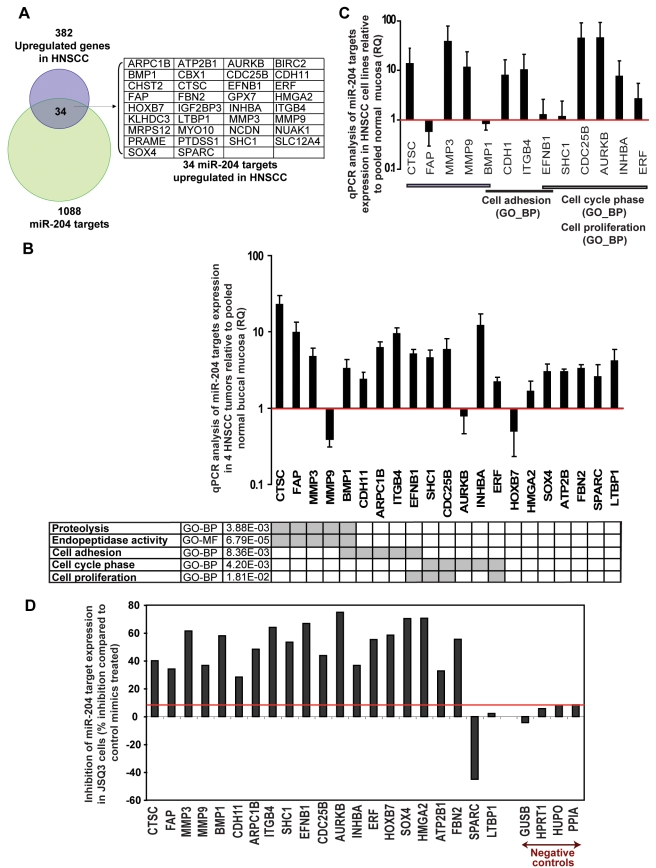
Predicted targets of miR-204 in HNSCC are significantly related via their molecular or biological functions.(A) Enrichment of 34 miR-204 gene targets between 382 differentially upregulated HNSCC genes (GSE6631) and 1088 putative miR-204 targets predicted by sequence-based microRNA target prediction databases (miRNOME); (B–C) Determination of mRNA expression of “functionally prioritized miR-204 targets” in four laser-microdissected HNSCC tumor samples (B) and in 10 HNSCC cell lines (C) by qPCR as described above in Figure 1 and in Materials and Methods). Five equally pooled normal buccal mucosa RNAs were used as the normal control. Legend: red line (RQ = 1) is the expression of the TBP endogenous gene control; error bars represent standard error of the mean; shaded squares in the GO table indicate gene targets in the corresponding “biological processes” (BP) and “molecular functions” (MF) of Gene Ontology (GO); adjusted P-values indicate the combined statistical enrichment of these genes in GO (Materials and Methods). (D) Ectopic enhancement of miR-204 function inhibited its predicted gene targets mRNA expression in JSQ3 HNSCC cell line. TBP expression was used as an endogenous gene control for normalization (red line) in the qPCR analysis.